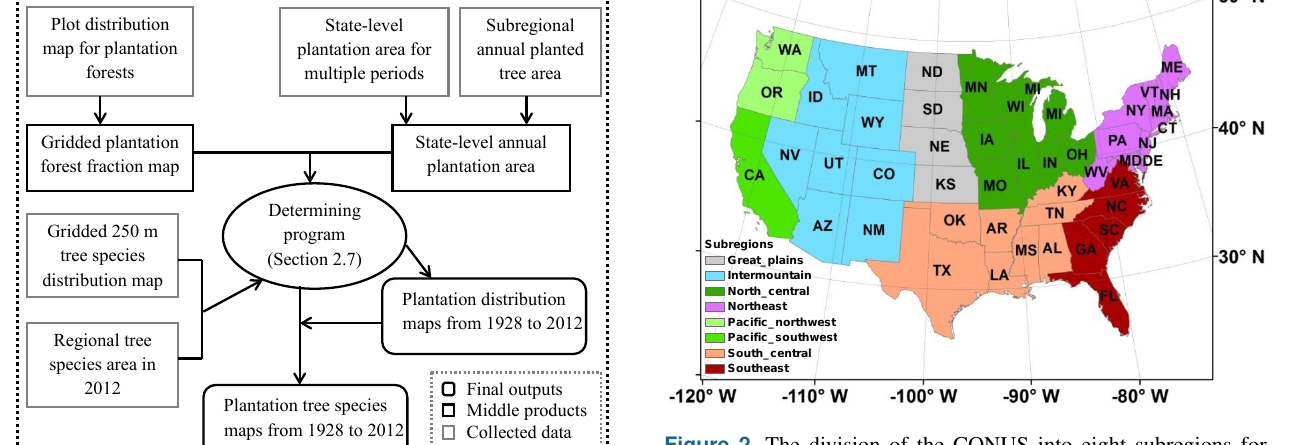
Figure 2. The division of the CONUS into eight subregions for data synthesis and analysis in this study. Note that three regions are further grouped in some reports, i.e., South (South Central and Southeast), North (Northeast and North Central), and West (Great Plains, Intermountain, Pacific Northwest, and Pacific Southwest). Data source: Smith et al.